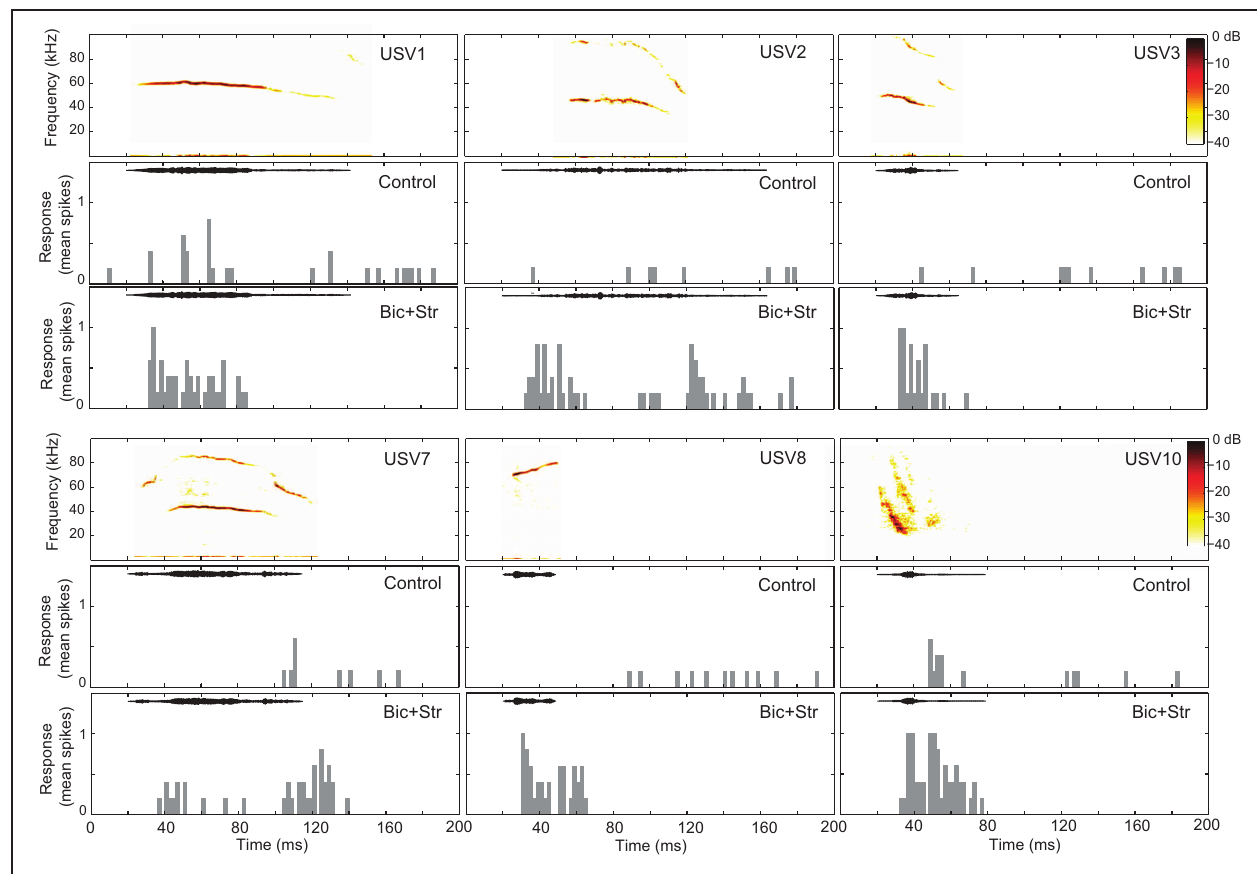
to only 6 of the 14 presented vocalizations are shown for clarity. SI values were 0.57 and 0 in the control and drug conditions, respectively. Bin width is 4ms.